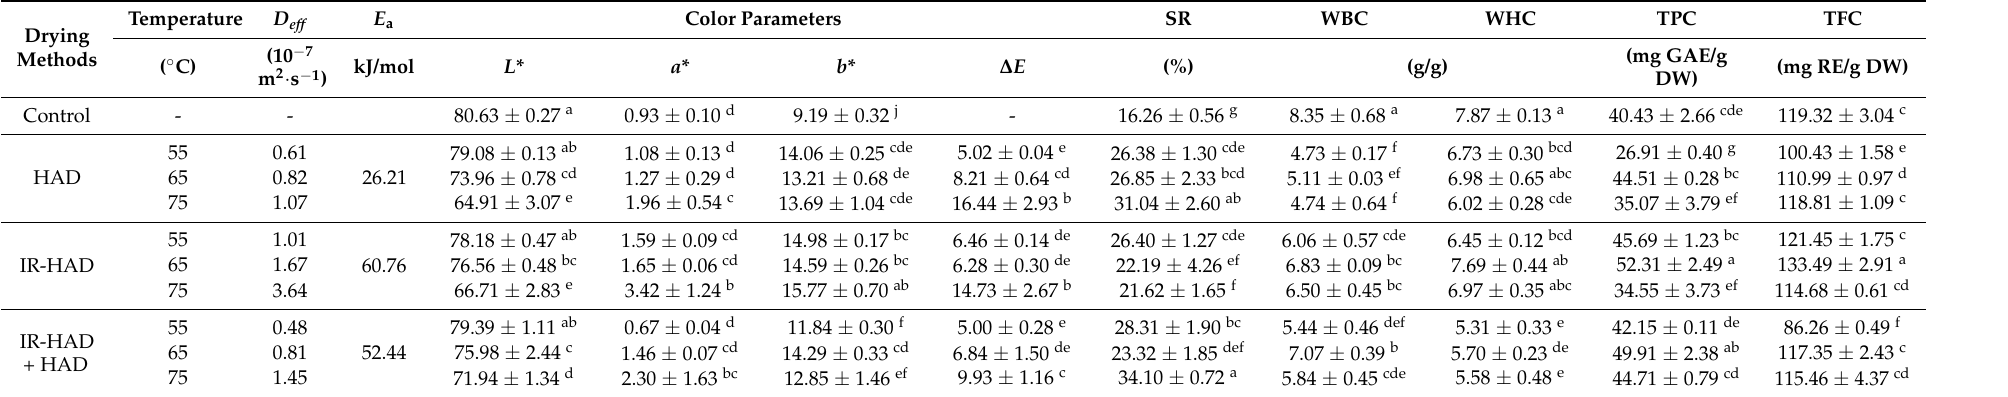
Table 2. Effective moisture diffusivity ( D eff ), activation energy ( E a )color parameters ( L *, a *, b *), color difference ( ∆ E ), shrinkage ratio ( SR ), water binding capacity ( WBC ), water holding capacity ( WHC ), total phenolic content (TPC), and total flavonoid content (TFC) of chrysanthemum cakes at different drying